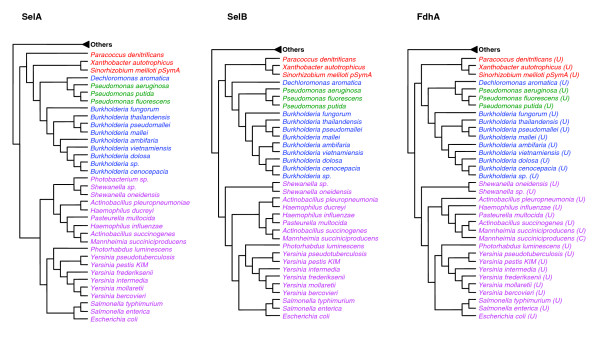
Phylograms of SelA, SelB, and FdhA sequences from Alphaproteobacteria, Betaproteobacteria, and Gammaproteobacteria. Organisms and phyla are shown by different colors. Red indicates Alphaproteobacteria, blue indicates Betaproteobacteria, green indicates Gammaproteobacteria/Pseudomonadales, and pink indicates other Gammaproteobacteria. In the FdhA phylogram, U represents Sec-containing sequences and C Cys-containing sequences.